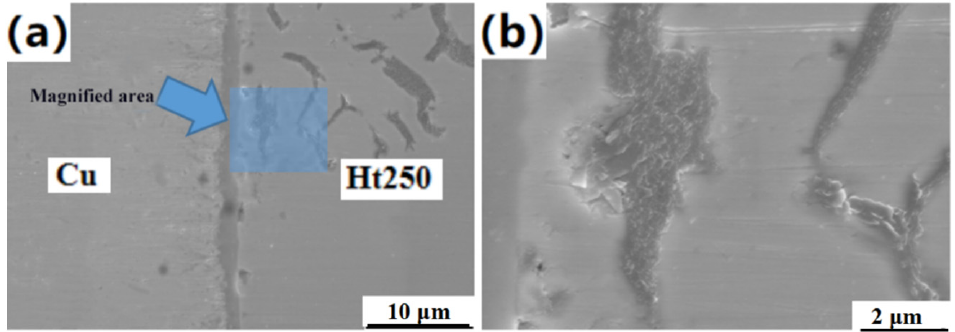
Figure 4. Enlarged view of graphite near the Ht250/Ti/Cu interface: ( a ) Schematic diagram of the location of the area to be swept; ( b ) enlarged view of the area to be swept.